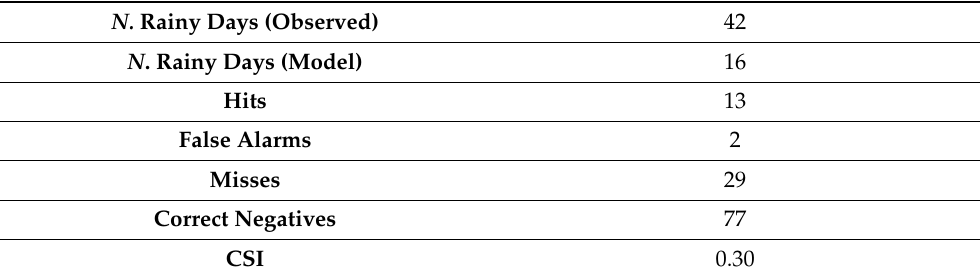
Table 3. Numerical values of the quantities defined from the contingency table.